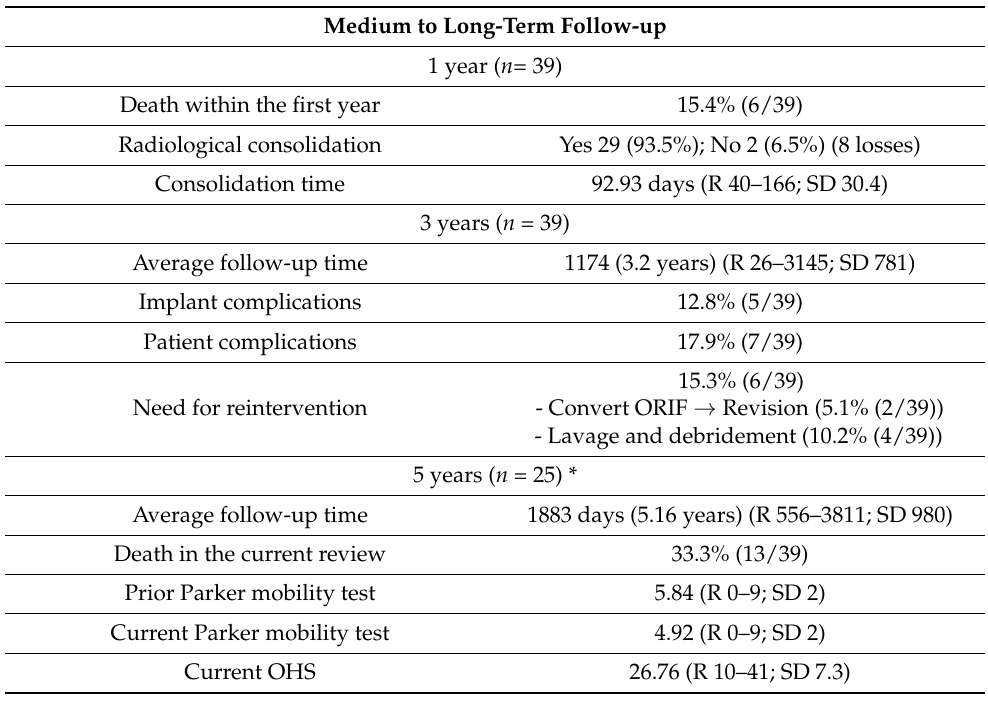
Table 1. Medium-long term assessment. * Current review: 25 patients (13 deaths and 1 follow- up